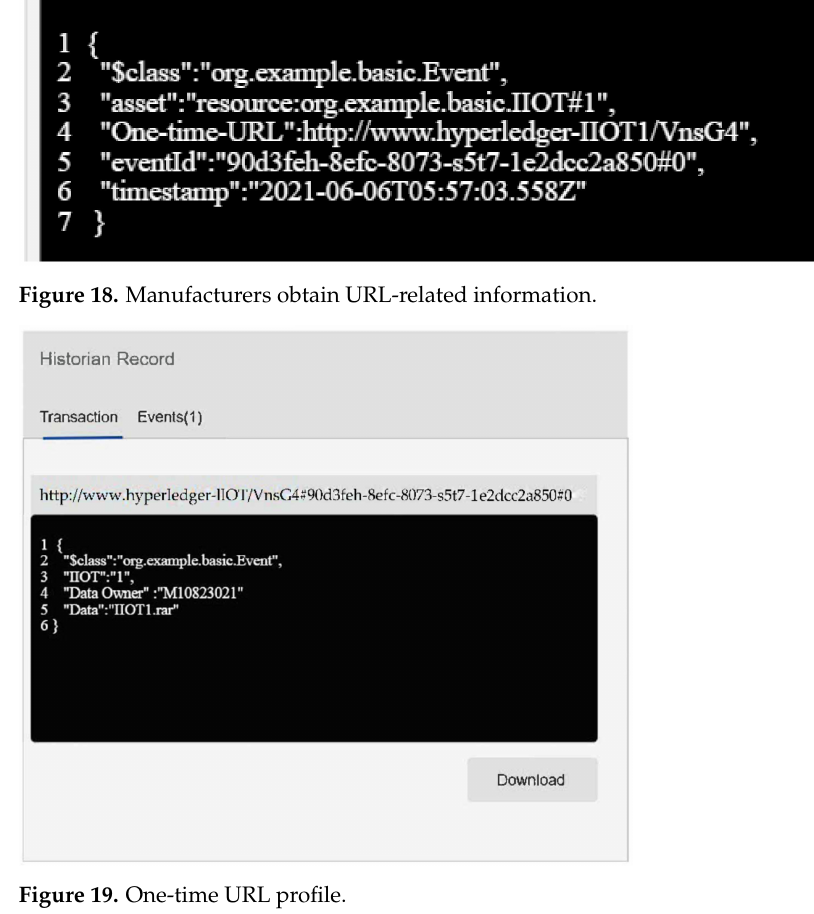
Figure 19. One-time URL profile.